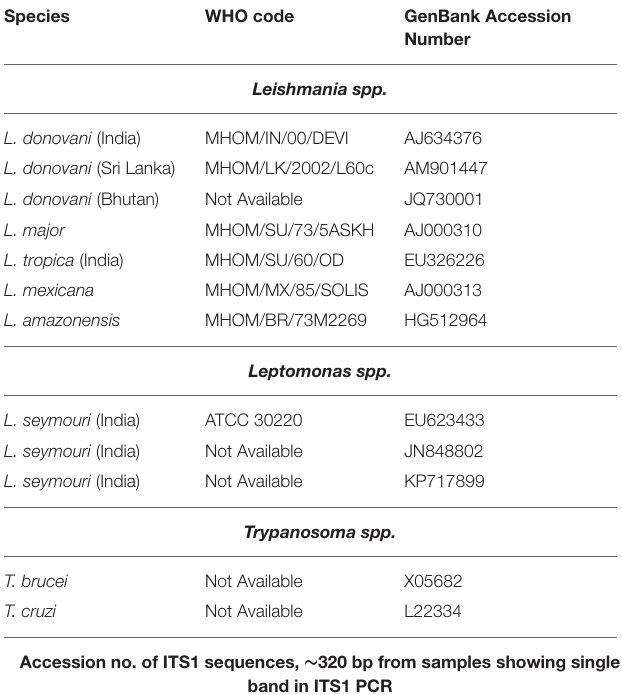
TABLE 1 | GenBank Accession Numbers of ITS1 sequences of standard Leishmania, Leptomonas, and Trypanosoma spp . and ITS1 test sequences from CL patients used in phylogenetic